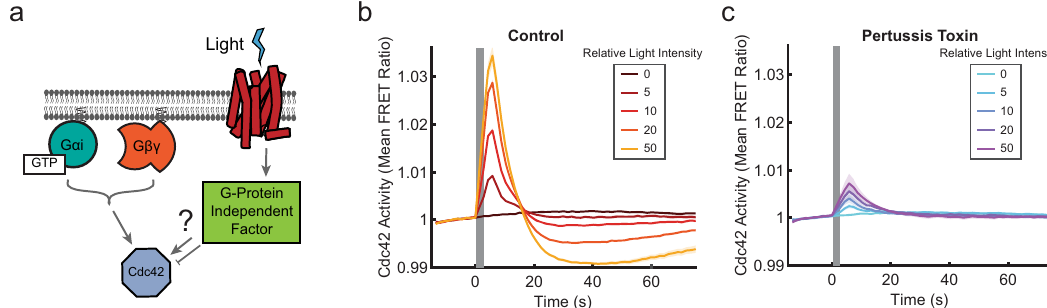
Fig. 5 Cdc42 is activated downstream of G i α family G proteins. a Schematic indicating the potential for Cdc42 response regulation independent of heterotrimeric G protein signals. b , c Single-pulse stimulations of populations of PLB-985 cells expressing parapinopsina and the Cdc42-TomKat sensor either without ( b ) or after treatment with 600 ng/ml Pertussis toxin (PTX) to inhibit G i α -dependent signals ( c ). b Data are presented as mean ± s.e.m of n = 16 for all conditions. c Data are presented as mean ± s.e.m ( n = 27 for relative light intensity = 0, n = 25 for relative well replicates well replicates well replicates light intensity = 5, n well replicates = 26 for relative light intensity = 10, n well replicates = 16 for relative light intensity = 20, and n well replicates = 16 for relative light intensity = 50). Stimulus duration is indicated by the gray bar. Source data are provided as a Source Data fi